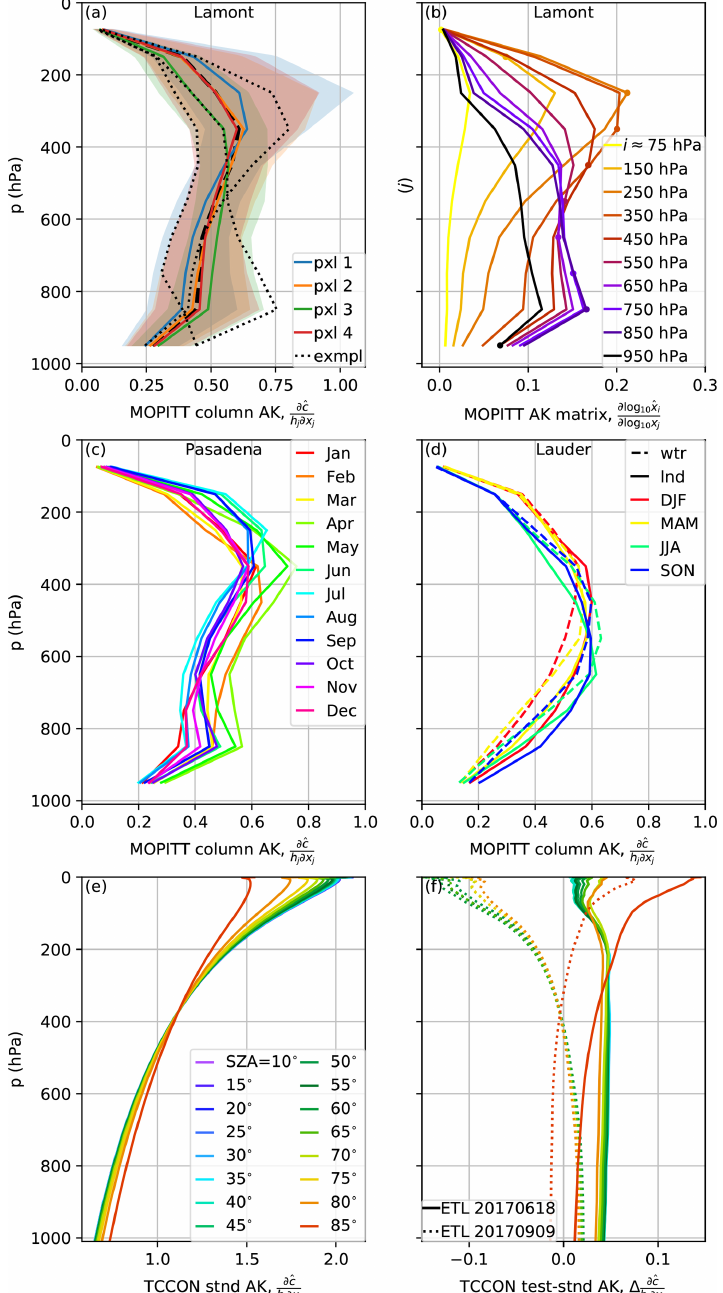
Figure 8. Examples of AKs from TCCON and MOPITT – subplots are not always related. MOPITT daytime AKs (a–d) are shown as center-point values along the y axis for clarity, though MOPITT retrievals are layer averages. Unitless MOPITT column AKs are generated using the methods of Appendix B. (a) MOPITT column AKs around Lamont for 2012–2013 separated by pixel. Filled areas are the central 80%, and solid center lines are the medians per level. Black lines are select examples from single soundings that show wide variability from sounding to sounding. The thicker example corresponds to the full AK in (b) . (b) Example MOPITT full AK from 16 October 2012. Dots highlight the i th level shown in the legend. (c) Median MOPITT column AK per level by month for Pasadena. (d) Median MOPITT column AK per level by season for land and water soundings for Lauder. (e) Standard TCCON GGG2014 AKs, which are assumed to be a function of only SZA and pressure. (f) Differences from AKs explicitly calculated at the ETL site on specific days compared to the standard AKs. For 18 June 2017, the mean of the ETL X CO is 74 . 0 ± 0 . 8ppb (1 σ ). For 9 September 2017, the mean of the ETL X CO is 169 ± 32ppb (1 σ ), with a range of